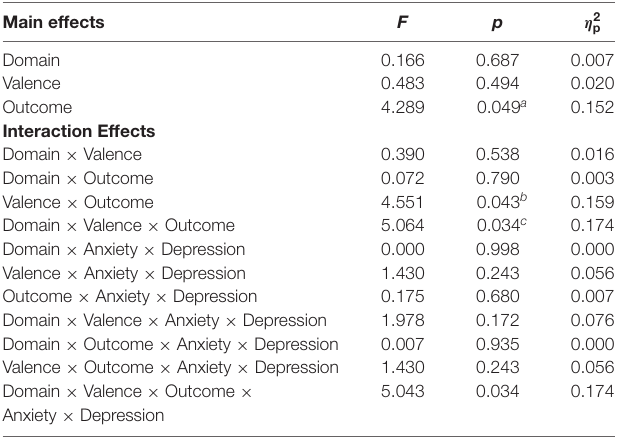
TABLE 1 | Results for the left ventral striatum Domain × Valence × Outcome × Anxiety × Depression ANCOVA.